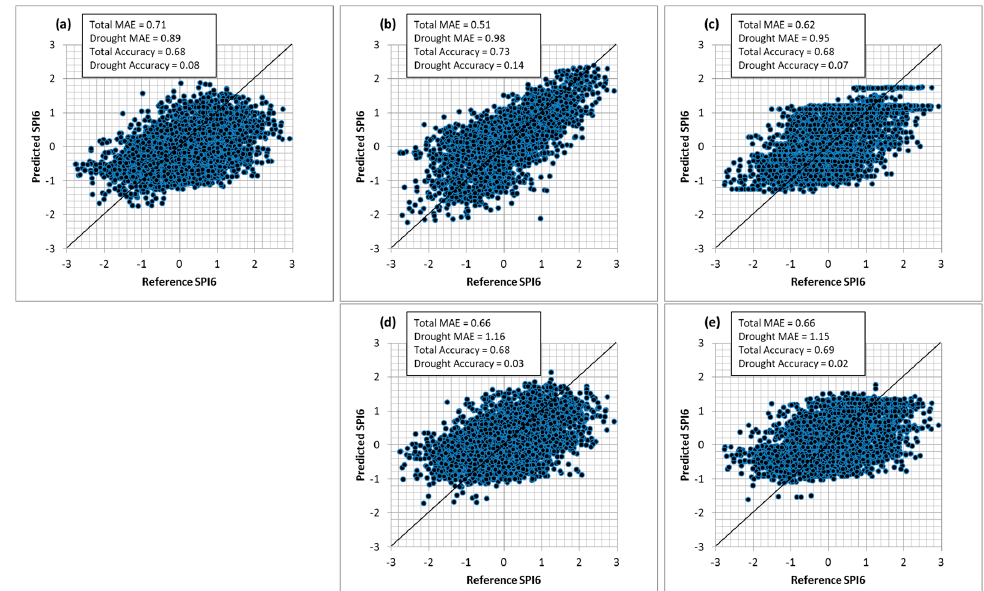
Figure 8. Scatter plots of reference SPI6 vs. 3-month lead SPI6 predictions for testing based on ( a )